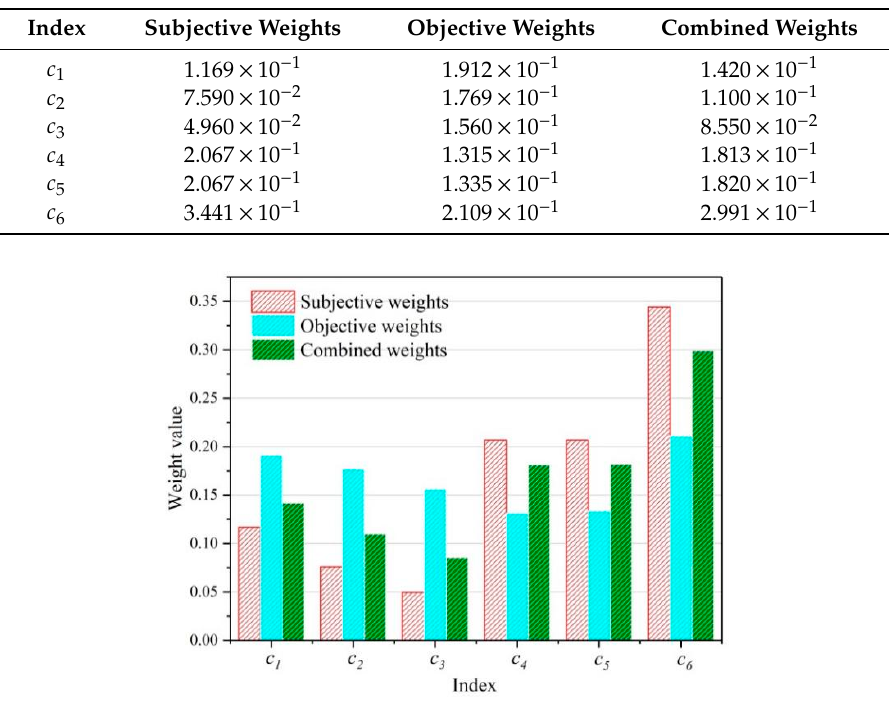
Figure 3. Combined weights of the qualitative indicators.